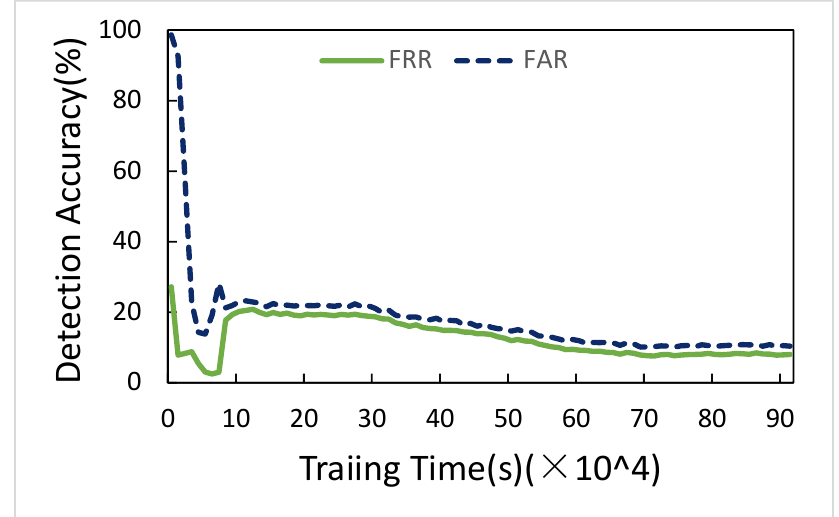
Figure 14. Performance of SCL.